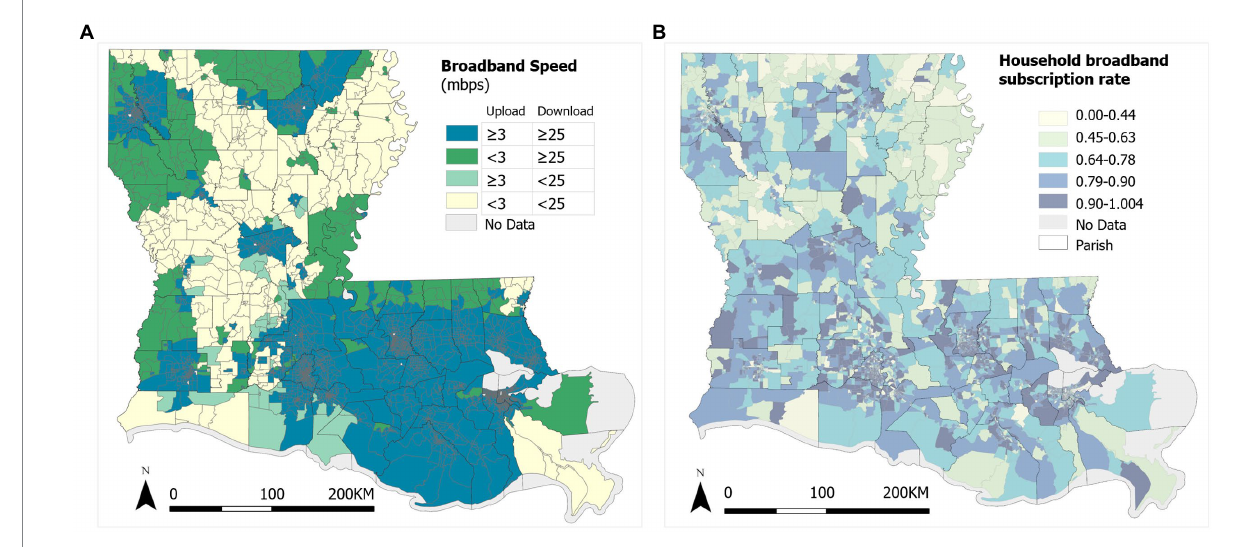
FIGURE 2 Broadband services in Louisiana: (A) Broadband download and upload speeds, and (B) subscription rates.